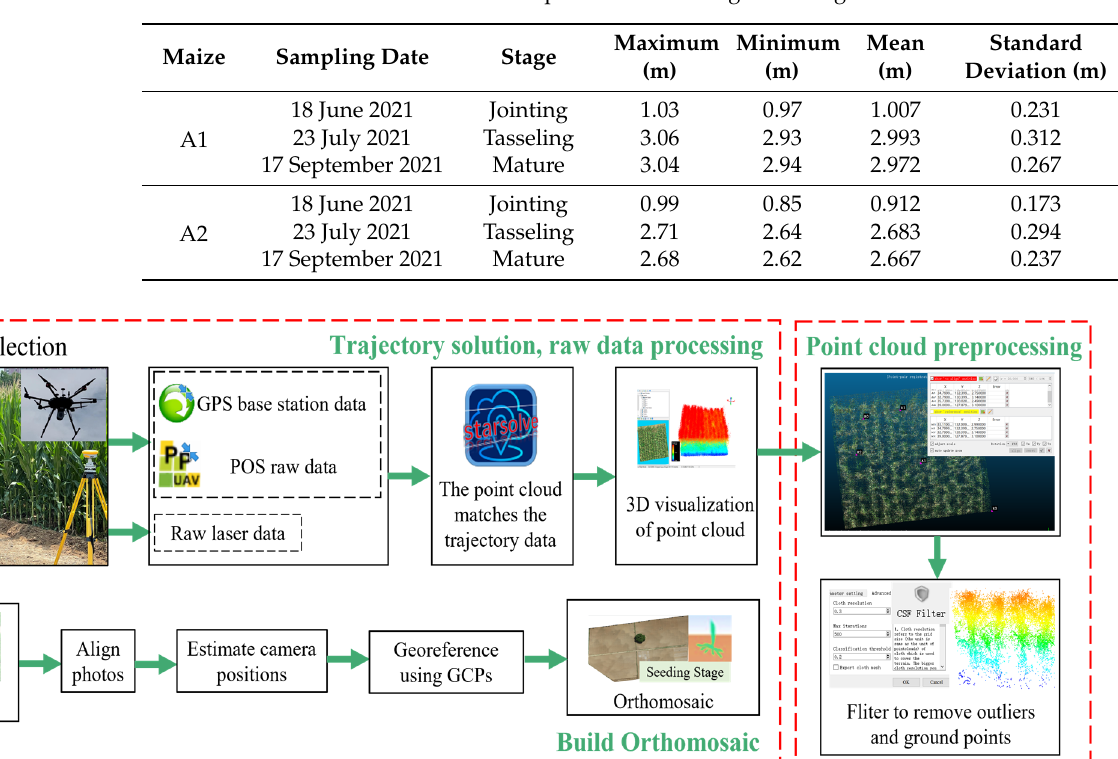
Table 3. Statistics of field measurements per maize at three growth stages.